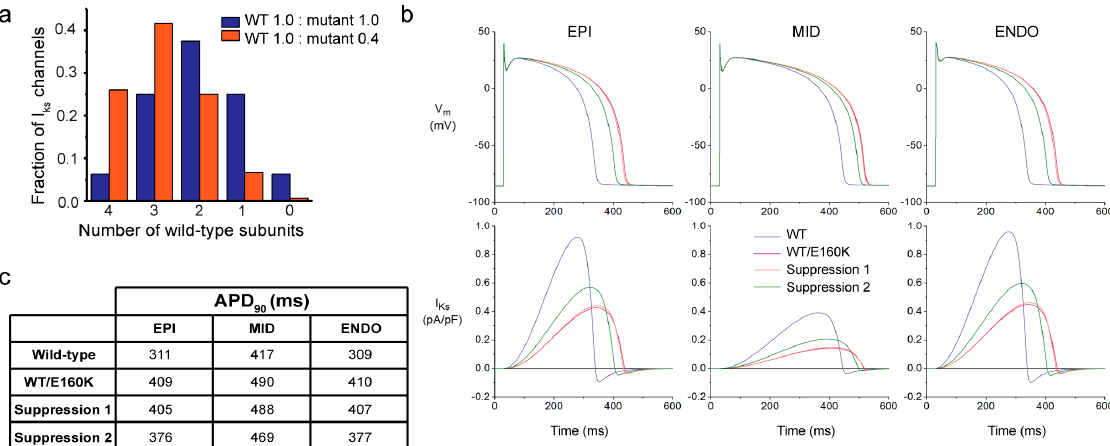
Figure 5. Computer simulation of allele-specific mutant KCNQ1 inhibition in an adult human cardiomyocyte: ( a ) Fraction of slow delayed rectifier potassium current (I Ks ) channels with 0-4 wild-type (WT) subunits in case of equal expression of wild-type and mutant KCNQ1 subunits (WT 1.0/mutant 1.0) and with a 60% suppression of mutant KCNQ1 subunits (WT 1.0/mutant 0.4) assuming random co-assembly of subunits into tetrameric channels; ( b ) Effects of changes in I Ks on action potentials of the epicardial (EPI), midmyocardial (MID), and endocardial (ENDO) versions of the human ventricular cell model. Membrane potential (V m ; top) and associated I Ks (bottom) at 1 Hz stimulation that result from simulations with 100% wild-type KCNQ1 expression (WT), with an equal heterozygous expression of wild-type and E160K mutant KCNQ1 subunits (WT/E160K), and with a 60% suppression of E160K mutant KCNQ1 subunits, assuming that all channels with mutant subunits contribute equally to mutant I Ks (‘Suppression 1’) or that only channels with one mutant subunit contribute to mutant I Ks (‘Suppression 2’). Note that the red and orange lines largely overlap; ( c ) Values of action potential duration at 90% of repolarization (APD 90 ) in each of the simulation